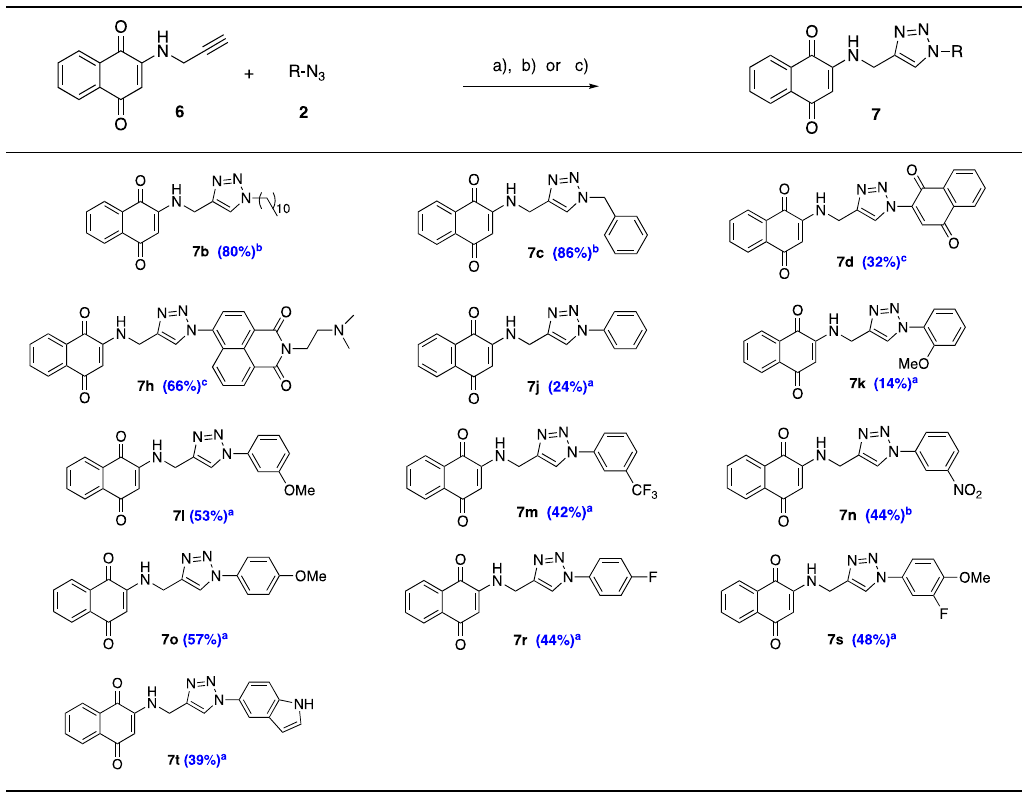
Table 3. Preparation of isosteric analogues of 1,2,3-triazole-naphthoquinones ( 7b–7d , 7h , 7j–7o , 7r–7t ).